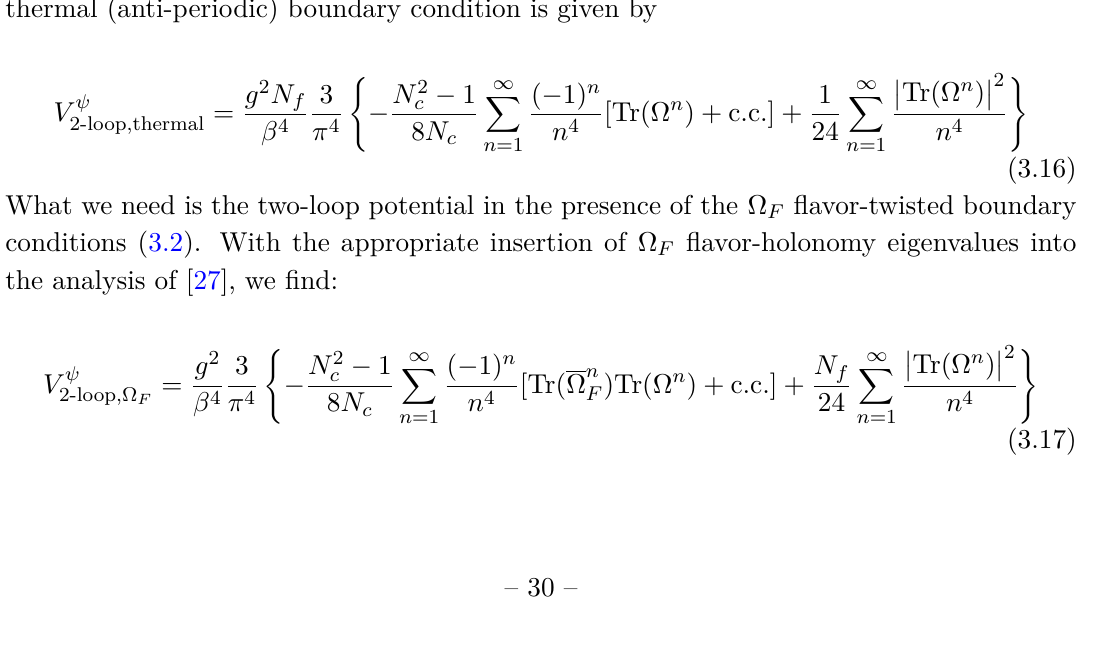
Figure 6 . The two-loop potential of twisted fundamental fermions g − 2 β 4 V ψ a function of the eigenvalues of the holonomy Ω = diag ( e iq 1 , e iq 2 , e iq 3 )